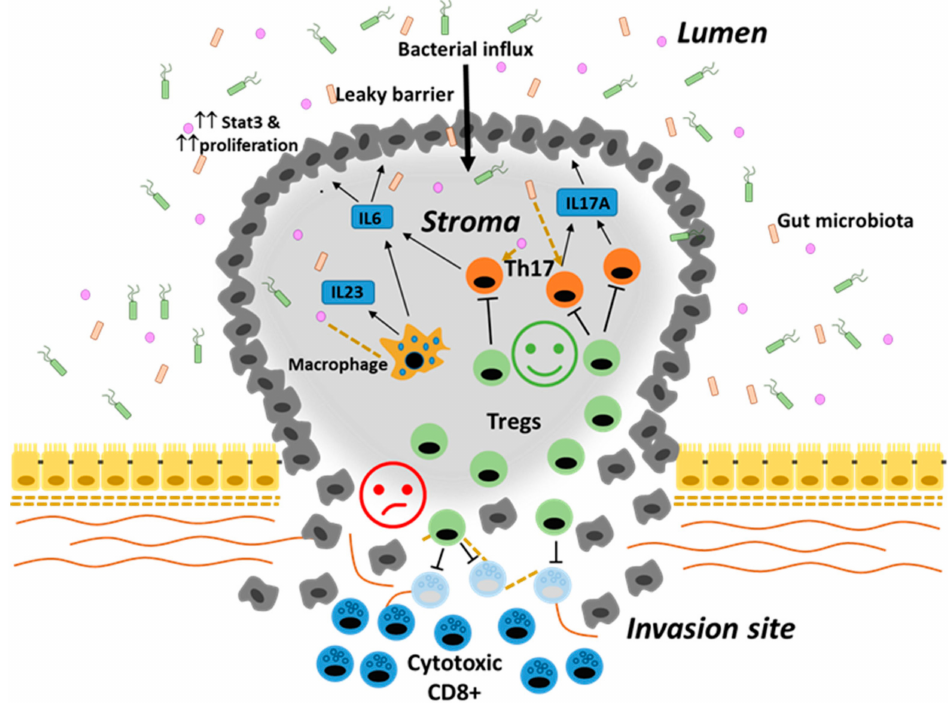
Figure 2. Dual role of Tregs in the TME: Tregs suppressive function against pro-tumorigenic inflammation evoked by bacterial antigens influx in the tumor stroma (smiling emoticon) and Tregs suppressive function against anti-tumor activity mediated by TAA-specific CD8 + cytotoxic cells (sad emoticon). Another subset of Tregs observed in sporadic CRC is characterized by the secretion of